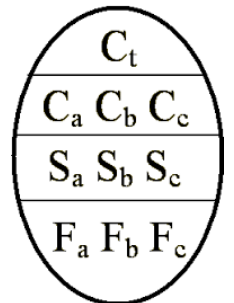
Figure 1. The World Meteorological Organization standard egg code used for ice charting at the Canadian Ice Service (WMO, 2014). The total concentration value, C t , is the code found on the first line of the egg code. Secondary concentration values ( C a ,C b ,C c ) can be found on the second line when more than one ice type is present.